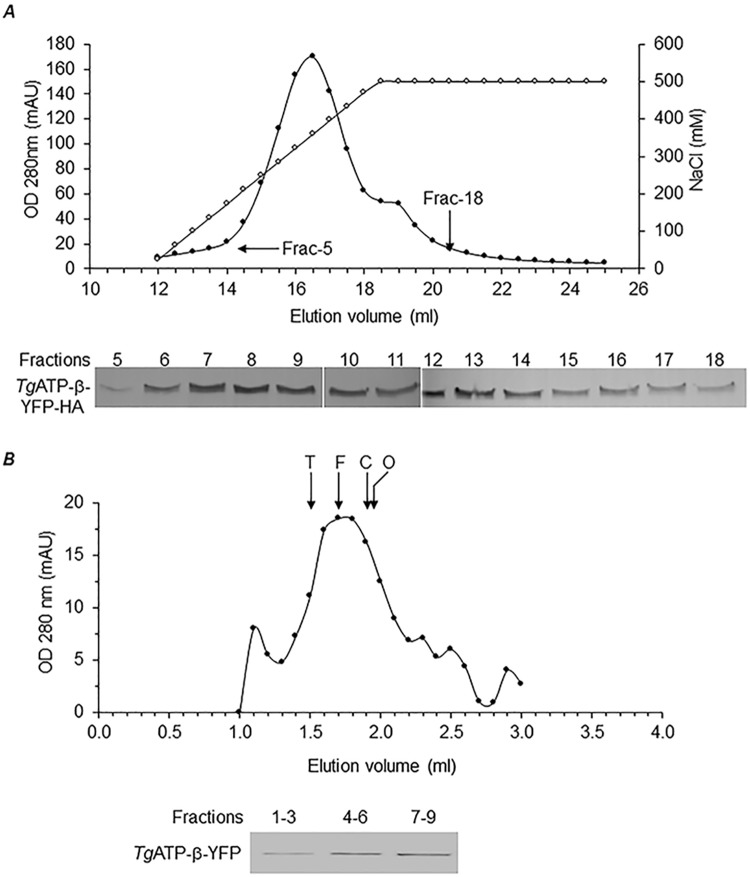
Partial purification of dimer and monomer forms of T. gondii F-type ATP synthase by chromatography.(A) Ion exchange (DEAE sepharose) separation of mitochondrial lysates prepared from TgATPβ-YFP-HA expressing transgenic parasites. Absorbance at 280 nm (filled circles) and NaCl concentration (open circles) are plotted for each fraction. Fractions 5 and 18 are marked with arrows. Bottom panel shows SDS-PAGE western blotting for fractions 5–18 to find out the elution profile of TgATPβ-YFP-HA. (B) Size exclusion profile of the pooled fractions from ion exchange chromatography. The absorbance at 280 nm is plotted for each fraction. The size exclusion column was calibrated with the following native markers: thyroglobulin (labeled “T,” 660 kDa), ferritin (labeled “F,” 440 kDa), conalbumin (labeled “C,” 75 kDa), Ovalbumin (labeled “O,” 45 kDa). Peak elution volume for each marker is indicated by arrow. Fractions 1–3, 4–6, and 7–9 were pooled, concentrated, and subject to SDS-PAGE western blotting to detect TgATPβ-YFP-HA, as shown in bottom panel. DEAE, diethylaminoethanol; OD, optical density; TgATPβ, T. gondii ATP synthase β subunit; YFP-HA, yellow fluorescent protein plus hemagglutinin.